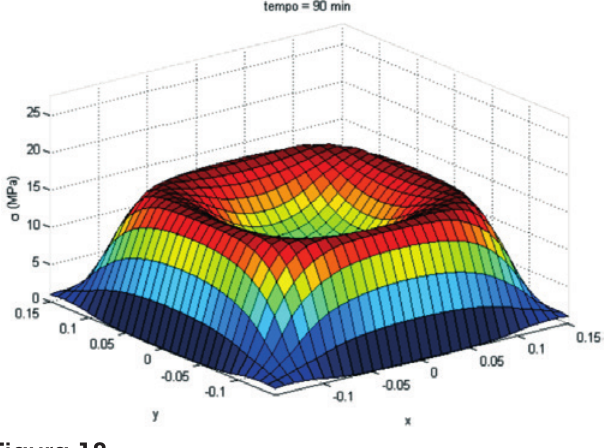
Figura 18 Campo de tensões da seção 30 cm x 30 cm com 4 ϕ 16 mm submetida à compressão